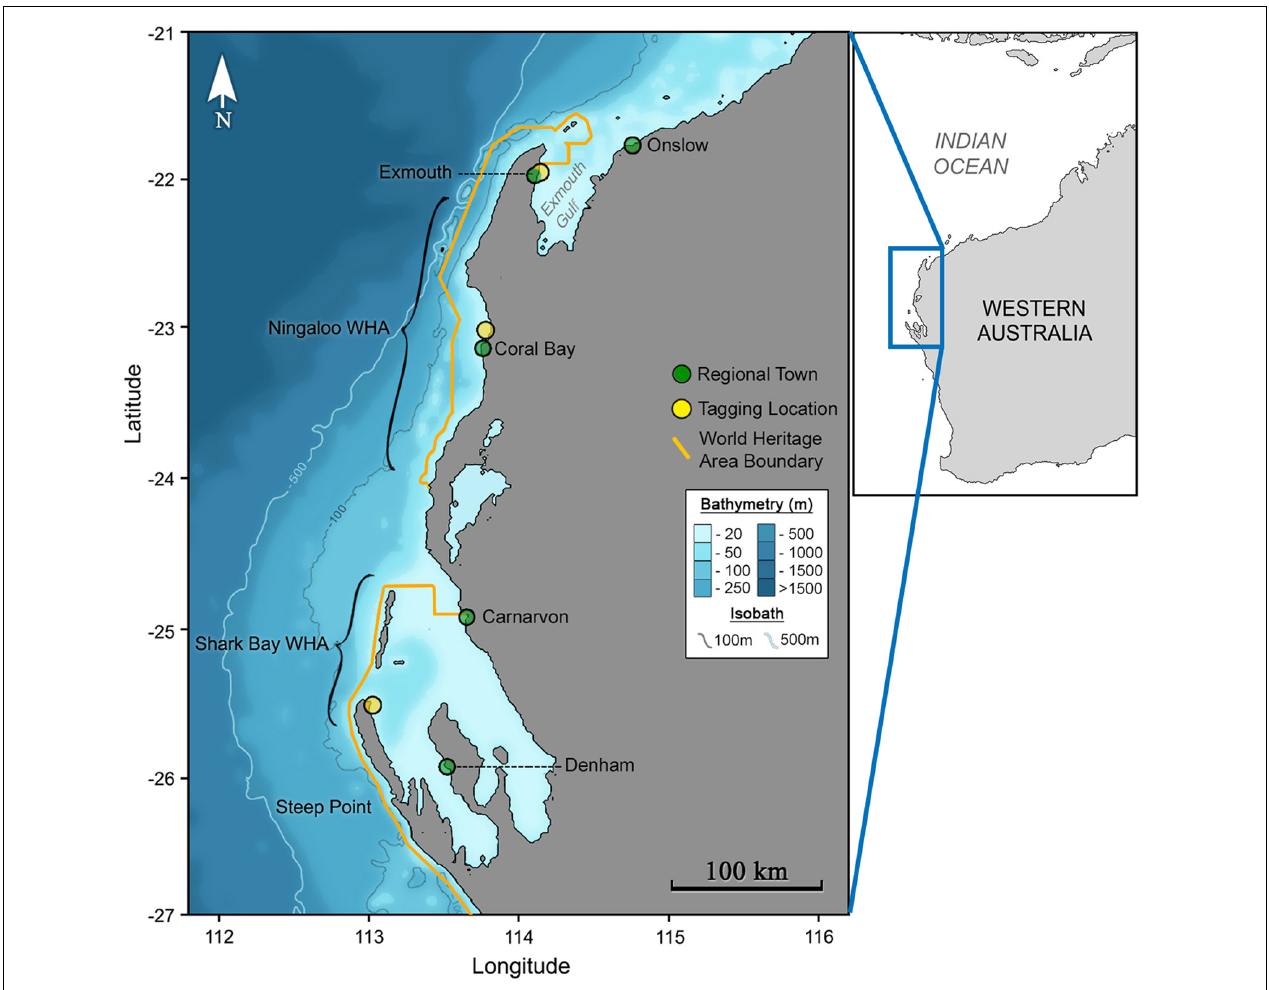
FIGURE 1 | The Ningaloo and Shark Bay World Heritage areas (inset) of Australia’s western coastline (outset) span vast regions of largely uninhabited